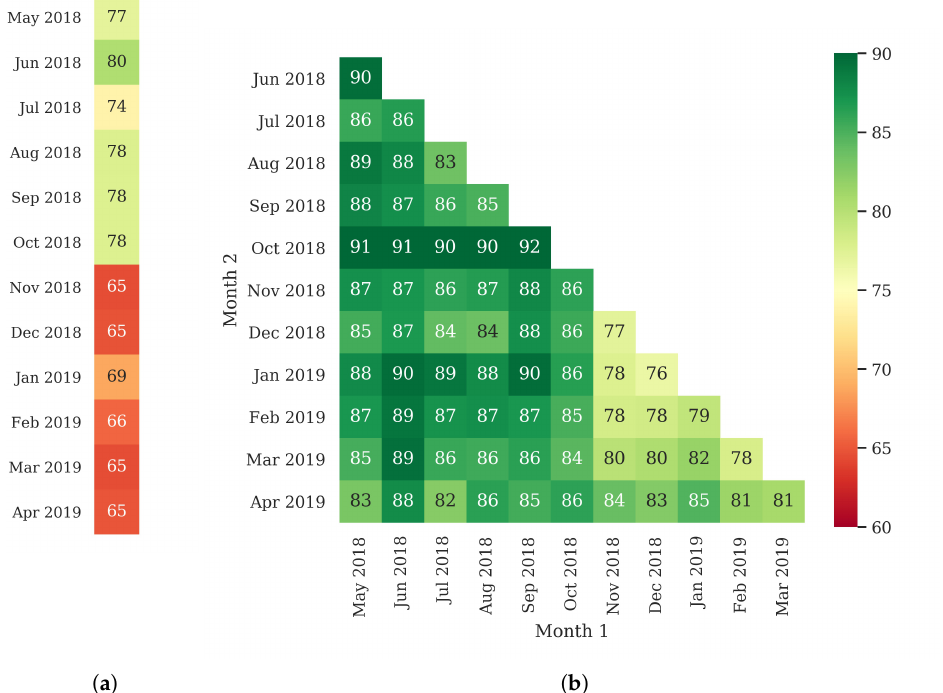
Figure 12. Sample classification accuracy for: ( a ) one month and ( b ) all combinations of two months S2 5-band